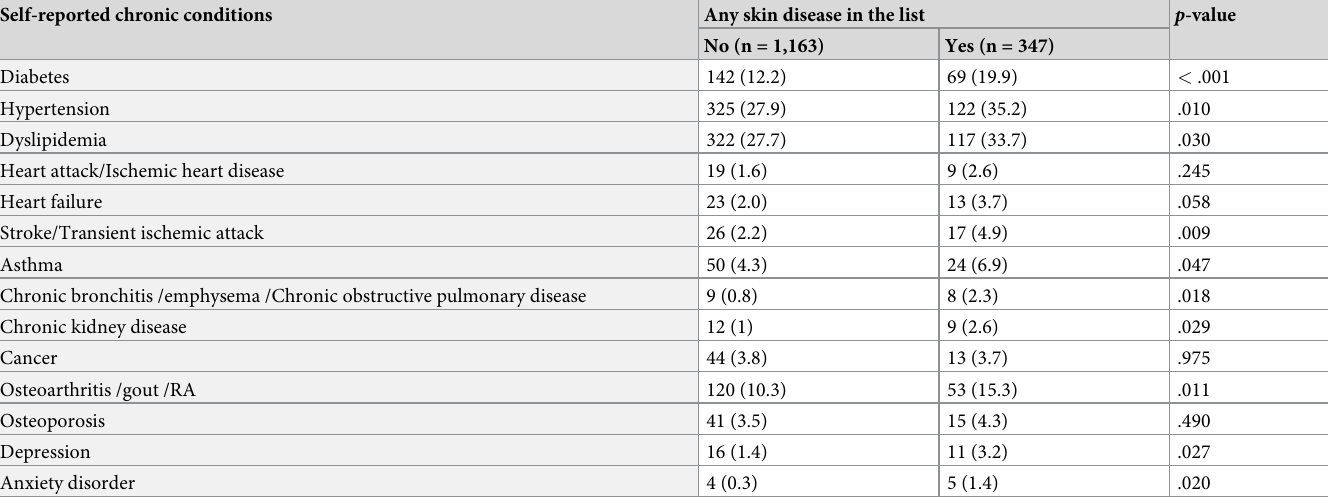
Table 3. Diagnosis of self-reported chronic conditions by history of any listed skin disease, n